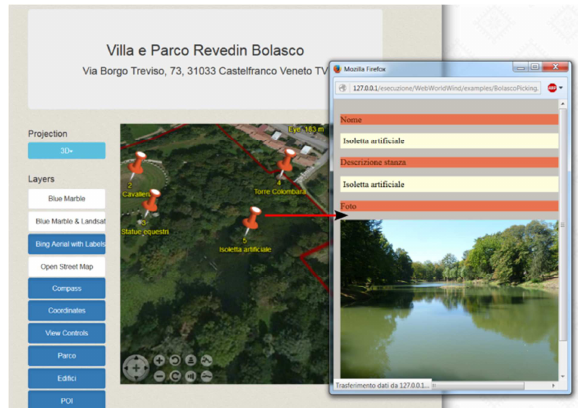
Figure 12. Information linked to a